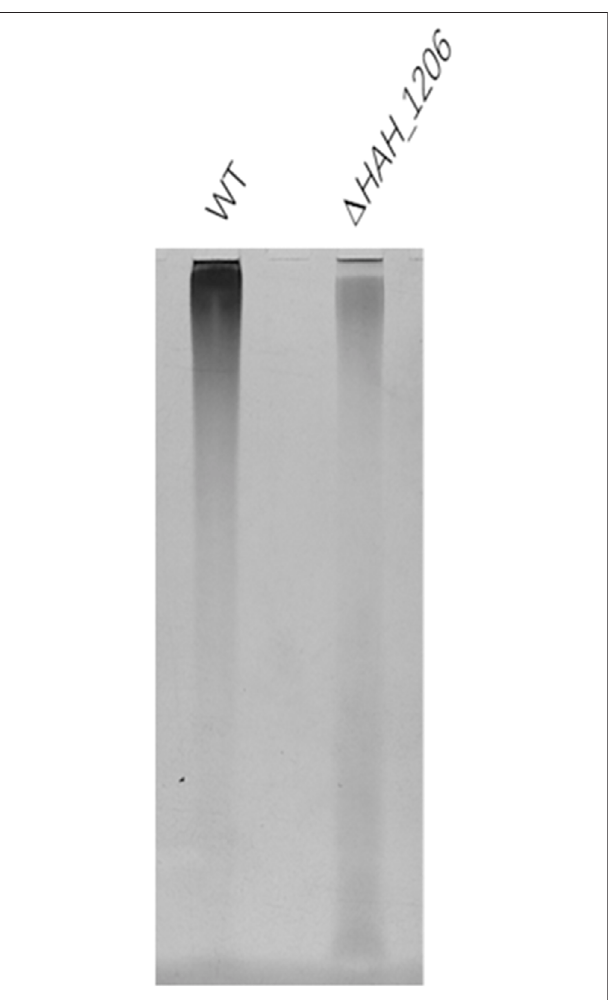
FIGURE 6 | Detection of sulfate in EPSs using the methyl blue method. EPSs (10 μ g) from wild-type H . hispanica and △ HAH_1206 were analyzed in 7.5% (w/v) SDS-PAGE, and sulfates in EPSs were stained with methyl blue.